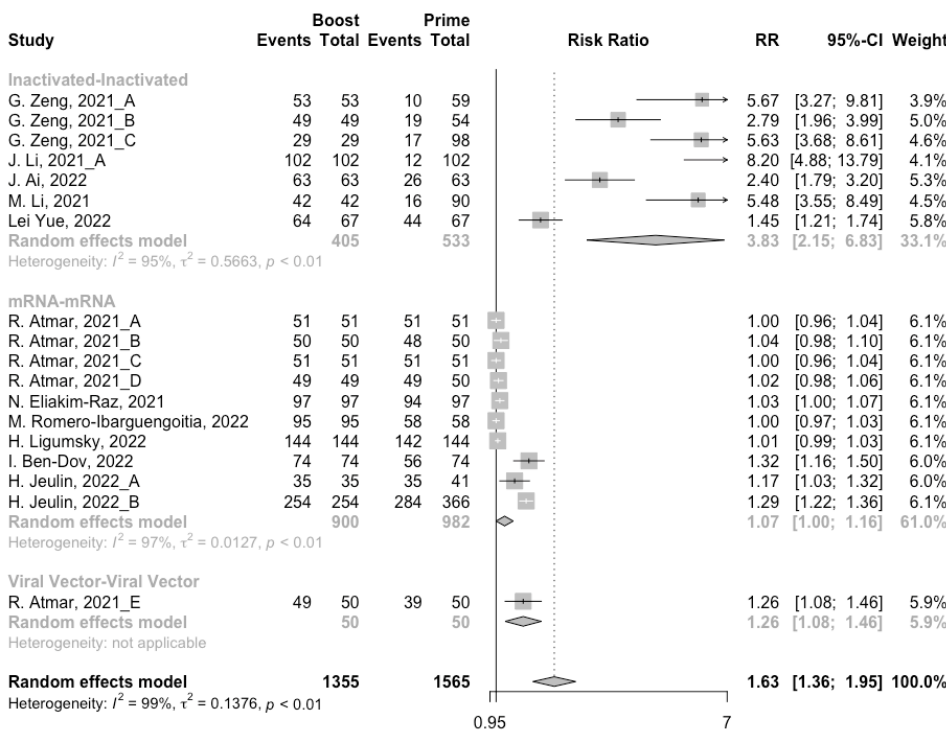
Figure 7. Forest plot of the pooled seropositive rate of antibodies before and after homologous booster vaccination.